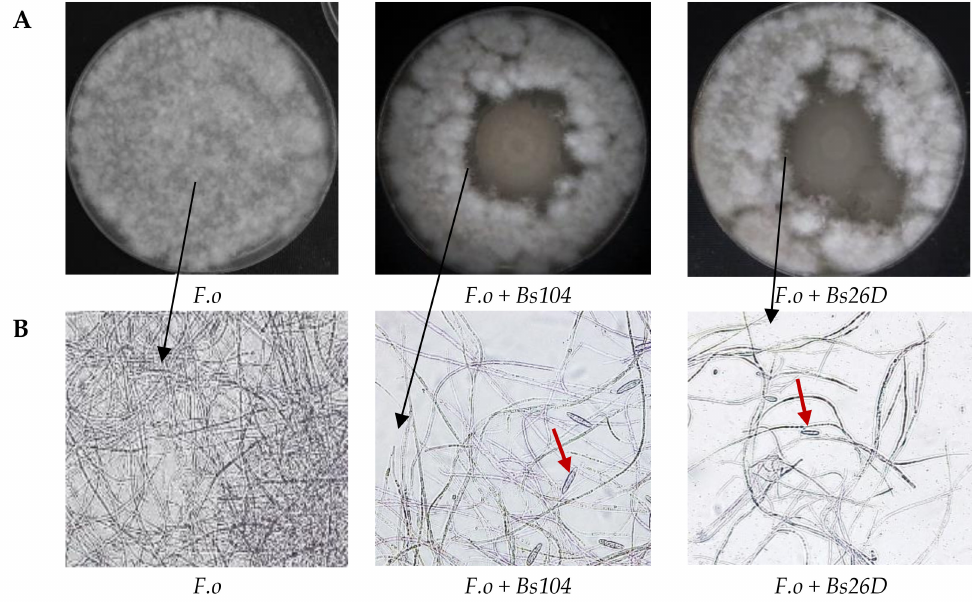
Figure 2. In vitro antagonistic activity of tested B. subtilis 10-4 (Bs104) and B. subtilis 26D (Bs26D) against the phytopathogenic fungus F. oxysporum (F.o) ( A ) and microscopic visualizations of the F. oxysporum fungal growth and morphology in the absence and presence of B. subtilis 10-4 and 26D ( B ). The observation was done using a scanning electron microscope Biozero BZ-8100E (Keyence Co., Osaka, Japan). F.o — F. oxysporum ; Bs — B. subtilis . Red arrows mean macroconidia produced by F. oxysporum